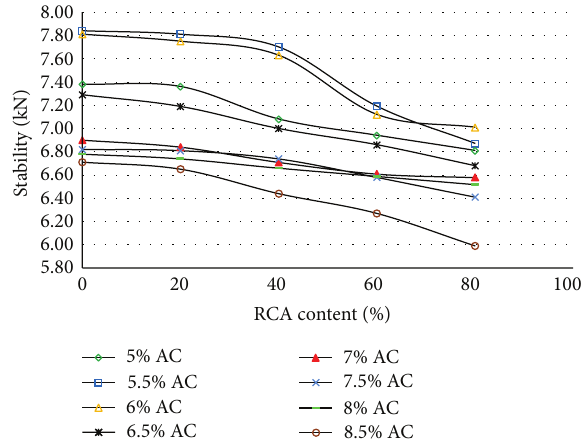
Figure 1: Marshall stability values versus RCA content for each percentage of asphalt content.